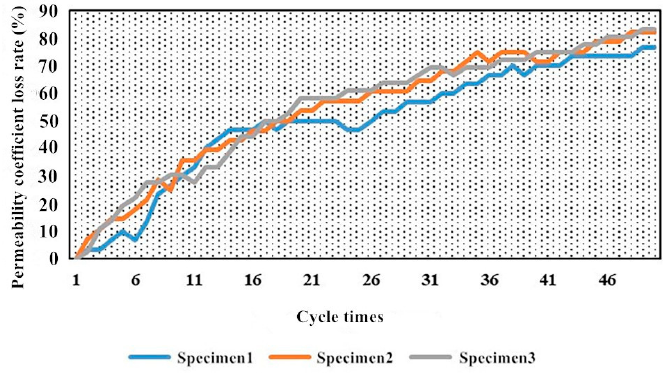
Figure 12. The change of the water permeability coefficient loss rate with the number of clogging cycles.